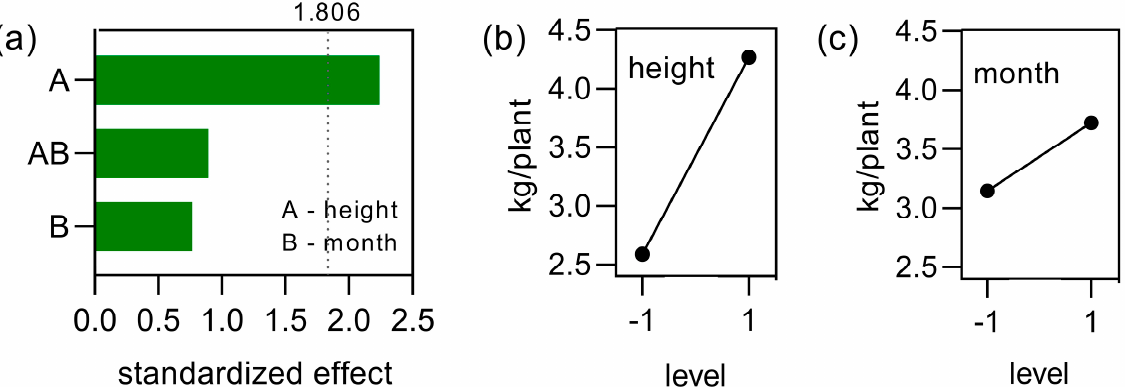
Figure 11. Factorial analysis of the experiment considering yield as response. Pareto chart of the standardized effects at p = 0.10 for yield of yerba-mate plants is shown in ( a ). The graphs of the main effects for yield considering variables height and month of cutting are shown in ( b ) and ( c ).